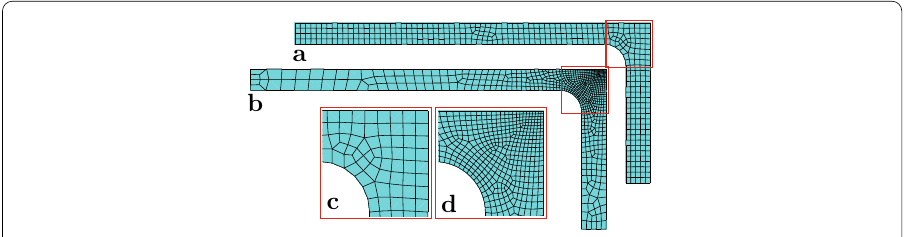
Fig. 13 The two different target configurations ( a ) and ( b ) with corresponding detailed views ( c ) and ( d ) which are used to evaluate the detachment of the target mesh form the mesh of the forming simulation in “Detachment of the target mesh from the mesh of the forming simulation”